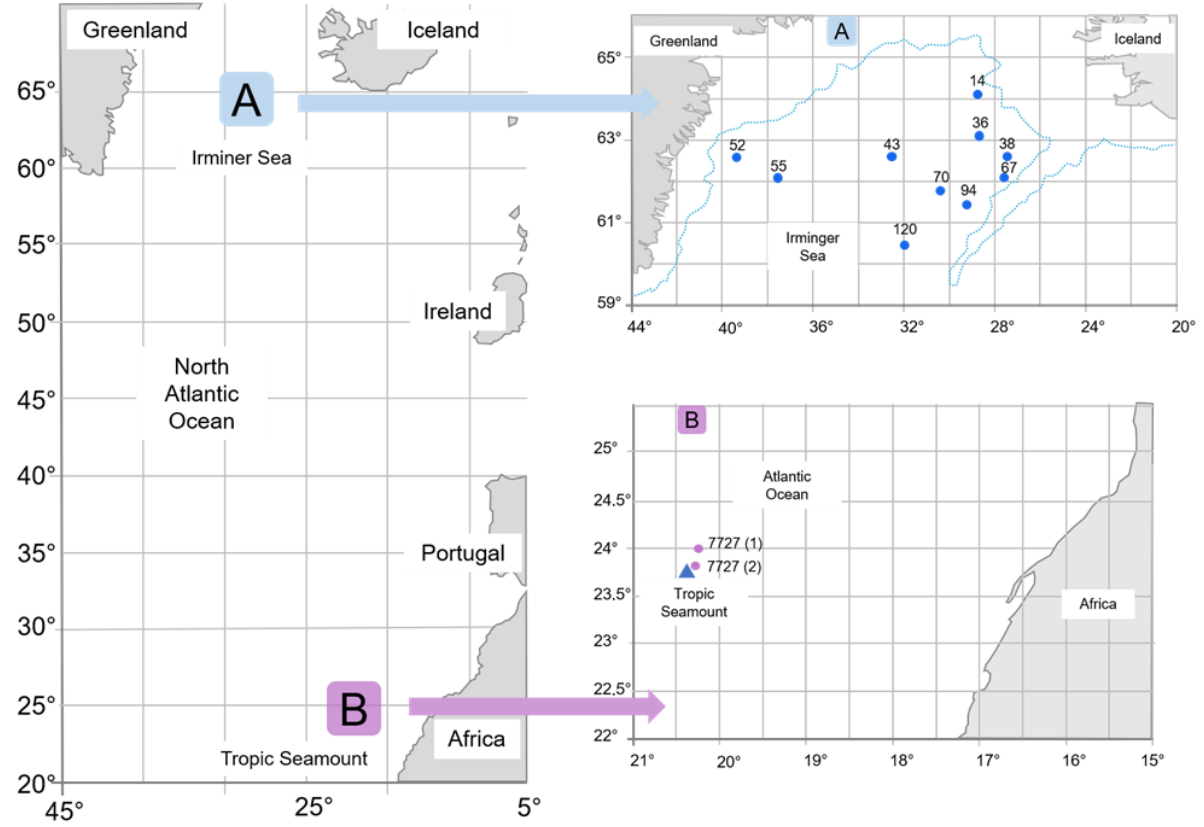
Figure 1. Schematic map of the collection sites of the mesopelagic fish ( A ) in the Irminger Sea ( Bathylagus euryops , Lampanyctus macdonaldi , Scopelogadus beanii , Serrivomer beanii ) and ( B ) in the Tropic Seamount area ( Lampanyctus alatus , Serrivomer beanii